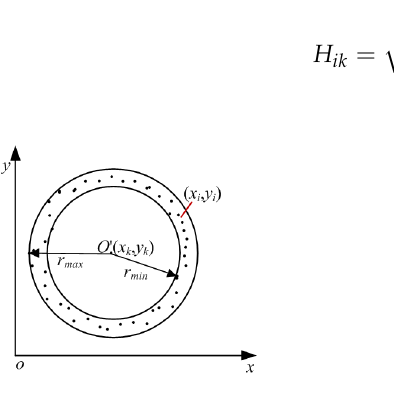
Figure 9. Schematic of roundness deviation evaluation.